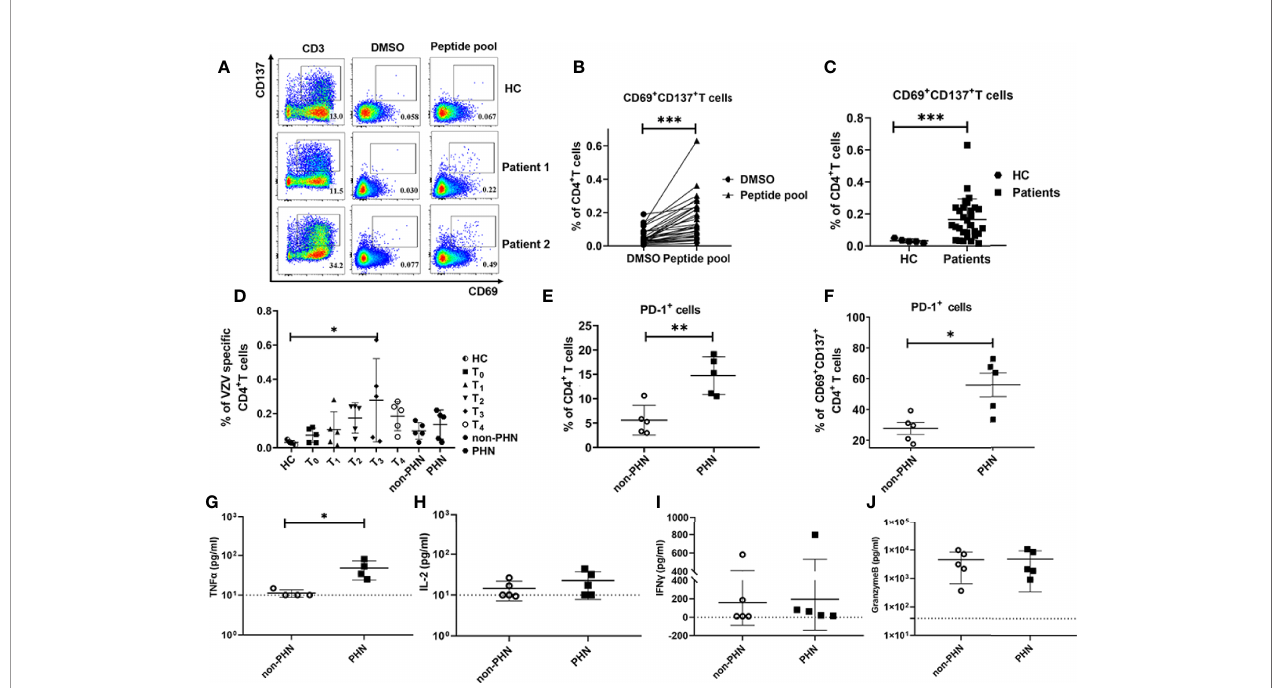
FIGURE 5 | Characteristics of VZV-speci fi c CD4 + T cell response. VZV-speci fi c CD4 + T cells assessed as frequencies of CD69 + CD137 + CD4 + T cells after stimulation of PBMCs by VZV peptide pools (gE, IE62, IE63). (A) Examples displaying the Fluorescence-activated cell sorting (FACS) plot, gated on total CD4 + T cells. The anti-human CD3 antibody group and DMSO group were performed as positive control and negative control, respectively. (B) Comparison of the frequency of VZV-speci fi c CD4 + T cells in peptide pools or DMSO stimulation. (C) Comparison of the frequency of VZV-speci fi c CD4 + T cells in patients and HC. (D) The characteristics of dynamics of VZV- speci fi c CD4 + T cells in patients at different time points after the onset of rash. (E, F) Frequencies of PD-1 + cells in total CD4 + T cells (E) and VZV-speci fi c CD4 + T cells (F) in PHN and non-PHN groups. (G-J) Different levels of cytokines in the cultured supernatants of PBMCs with VZV peptide pools stimulation in PHN and non-PHN groups. (G) TNF- a , (H) IL-2, (I) IFN- g , (J) Granzyme B. *P < 0.05, **P < 0.01, ***P <